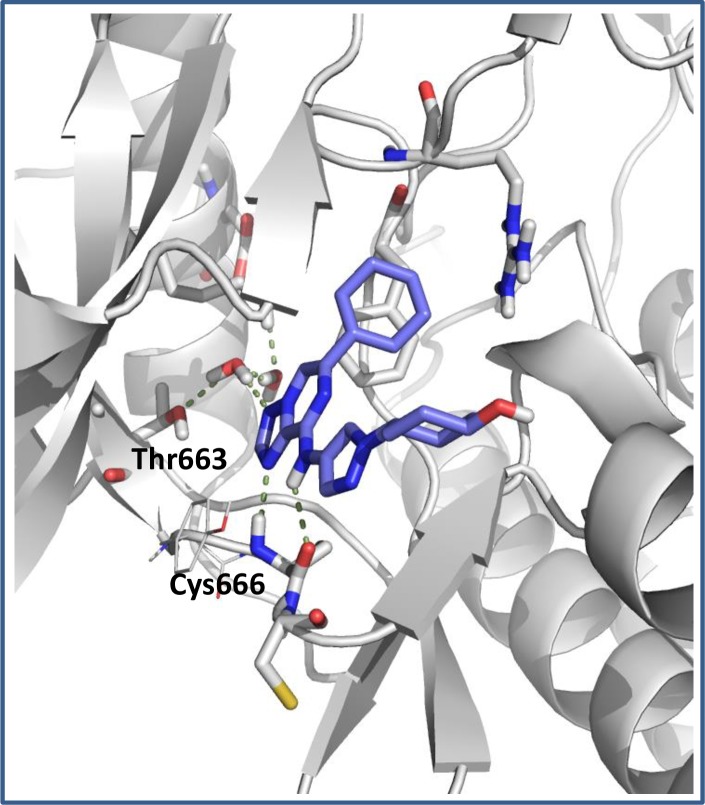
Model of compound 1 with CSF1R.Modeled using the Schrodinger Maestro Glide docking into a grid generated from the CSF1R X-ray crystal structure (PDB Code: 2I0Y) followed by optimization with MM-GBSA [39].